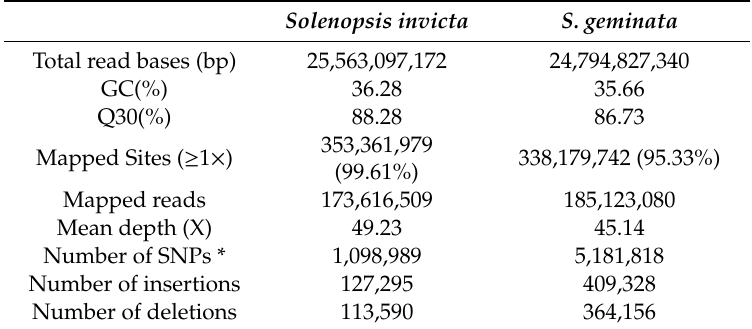
Table 1. Summary of the next-generation sequencer (NGS) sequencing of collected Solenopsis invicta and S.